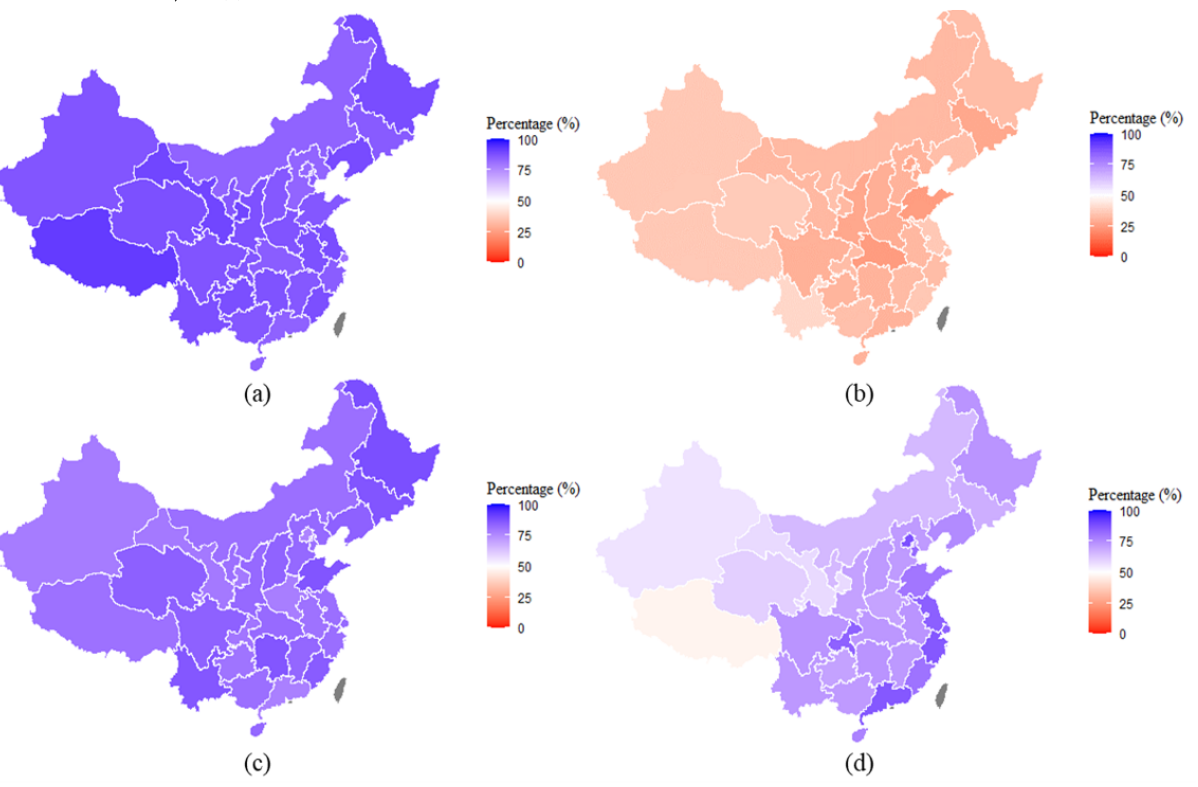
Figure 2. The proportion of the population by province with correct responses to questions about (a) prevention methods, (b) common misconceptions, (c) transmission channels, and (d) recommended actions after